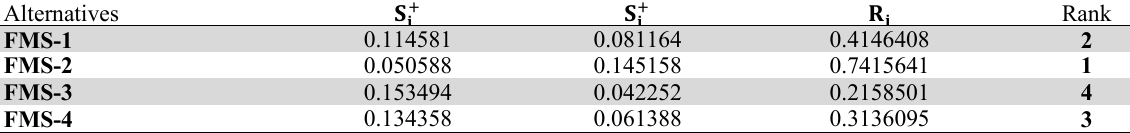
Separation measures, relative closeness and ranking of each alternative